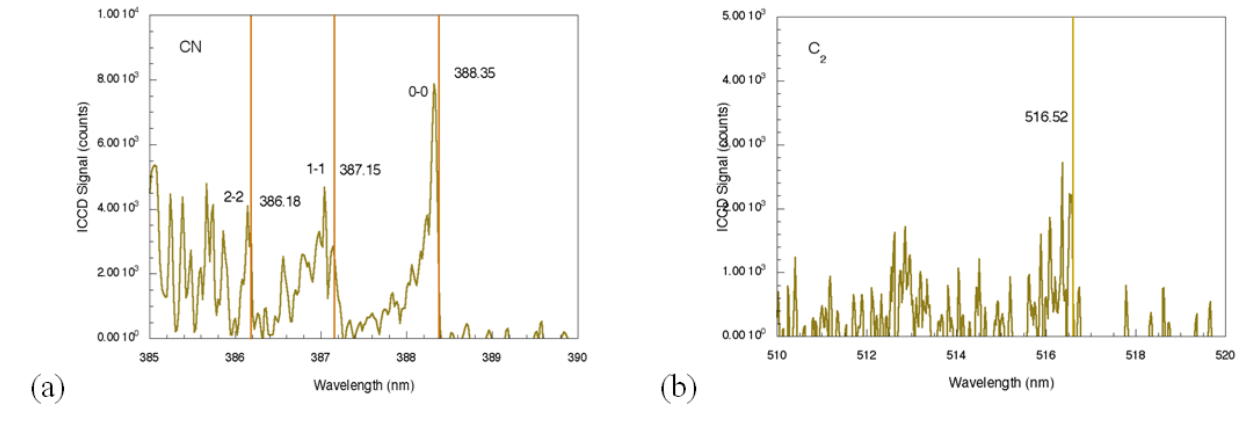
Figure 4. Higher resolution spectra of selected regions of the spectrum obtained for femtosecond excitation of TNT on aluminum. (a) Expanded view of emission from CN. . The detection gate delay and width were 100 ns (b) Expanded view of emission from C 2 and 1 µs,